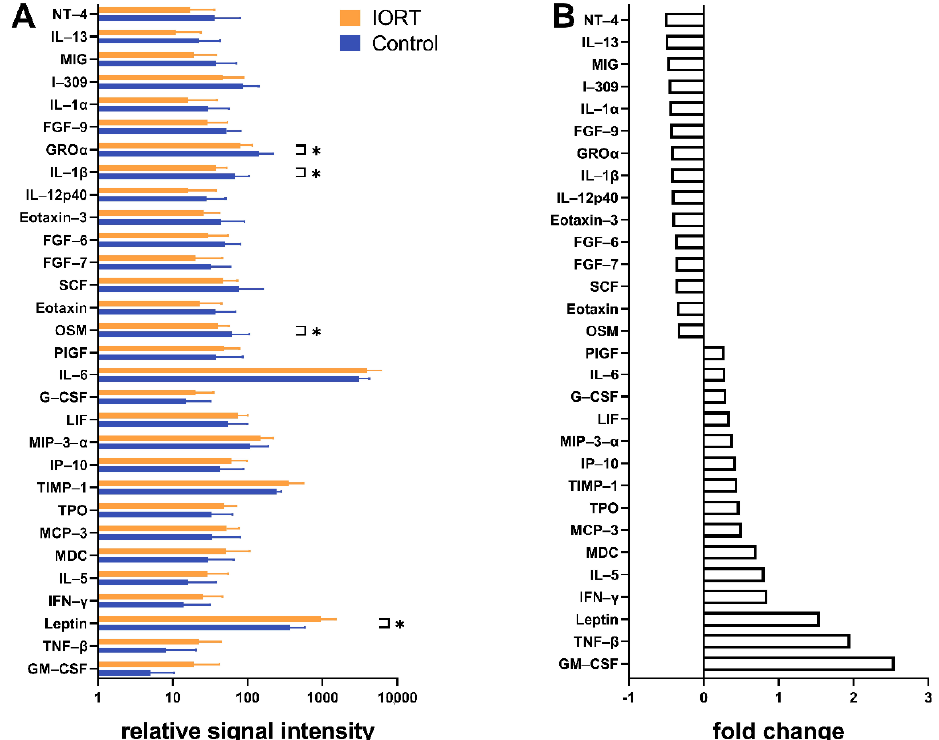
Figure 2. Signal intensities and calculated fold changes of the 30 cytokines with most differing levels between IORT and control group in the human cytokine array. ( A ): relative signal intensity, ( B ): fold change (>0: higher levels in IORT-WF; <0: higher levels in control-WF). N = 8 IORT vs. N = 7 control. Indicated values: mean ± standard deviation, statistical analysis by double sided t -test, * p < 0.05.